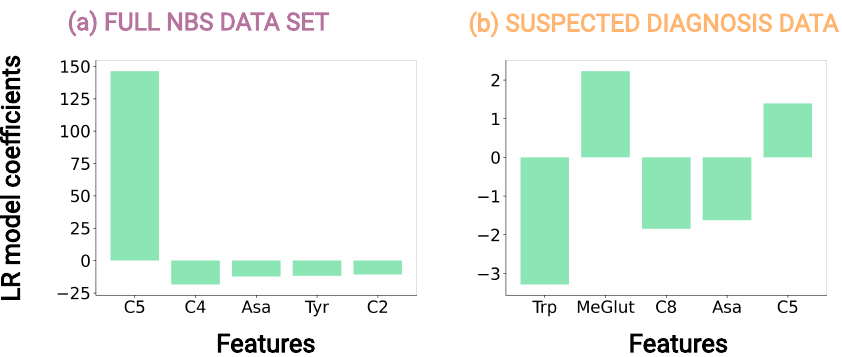
Figure 4. LR model coefficients graph, showing the five highest absolute LR coefficients of the LR models on ( a ) full data set and ( b ) suspected diagnosis data set on all features.